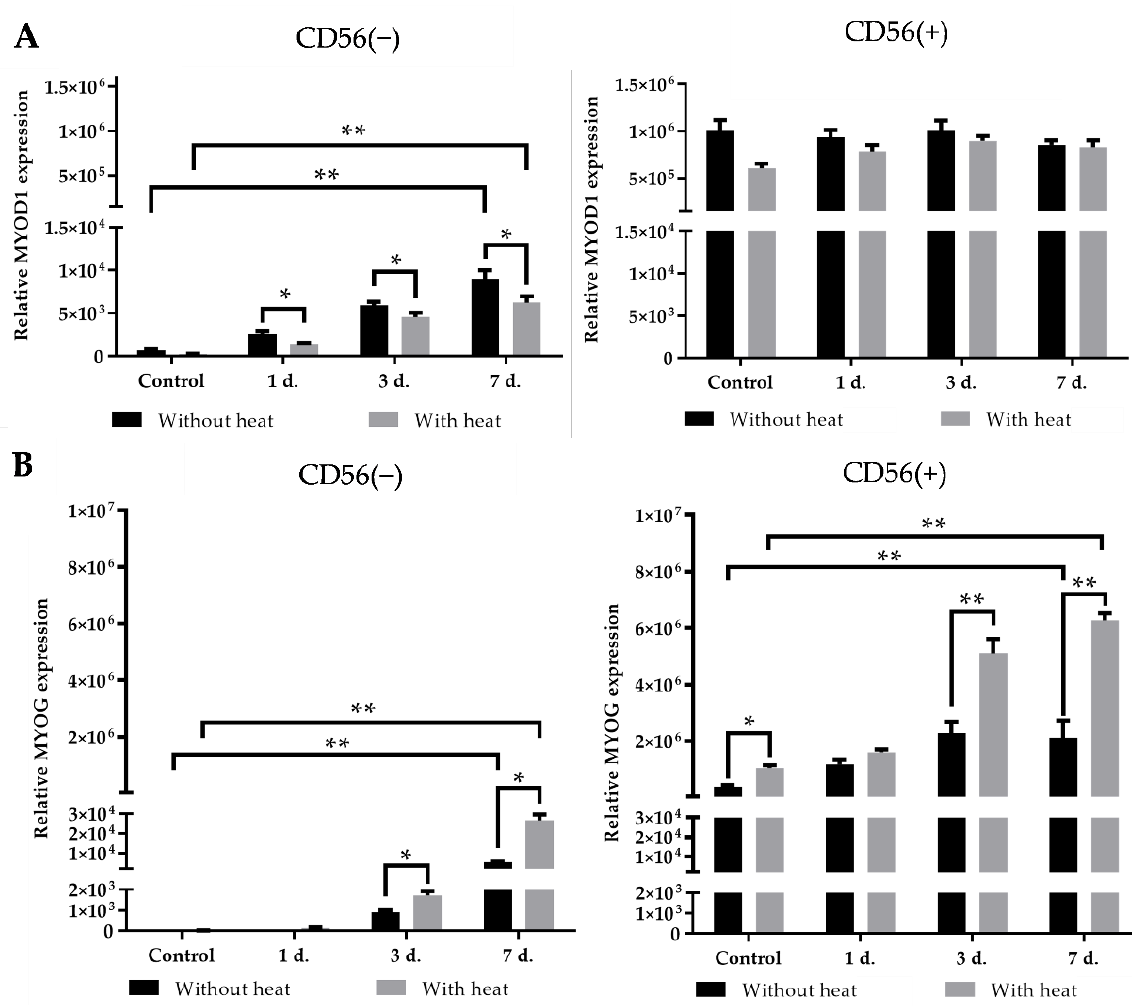
Figure 7. The effect of heat stimulus on the expression of myogenic transcription factors in CD56( − ) and CD56(+) subpopulations during 7 days of differentiation. ( A ) Expression of MYOD1 in CD56( − ) and CD56(+) cells with and without heat stimulus; ( B ) expression of MYOG in CD56( − ) and D56(+) cells with and without heat stimulus. Data are shown as mean ± standard deviation (SD) from not less than three repeats ( n = 3) and three cell cultures and are significant at * p ≤ 0.05 and ** p ≤ 0.01 levels calculated using the Graphpad Prism 6 software.